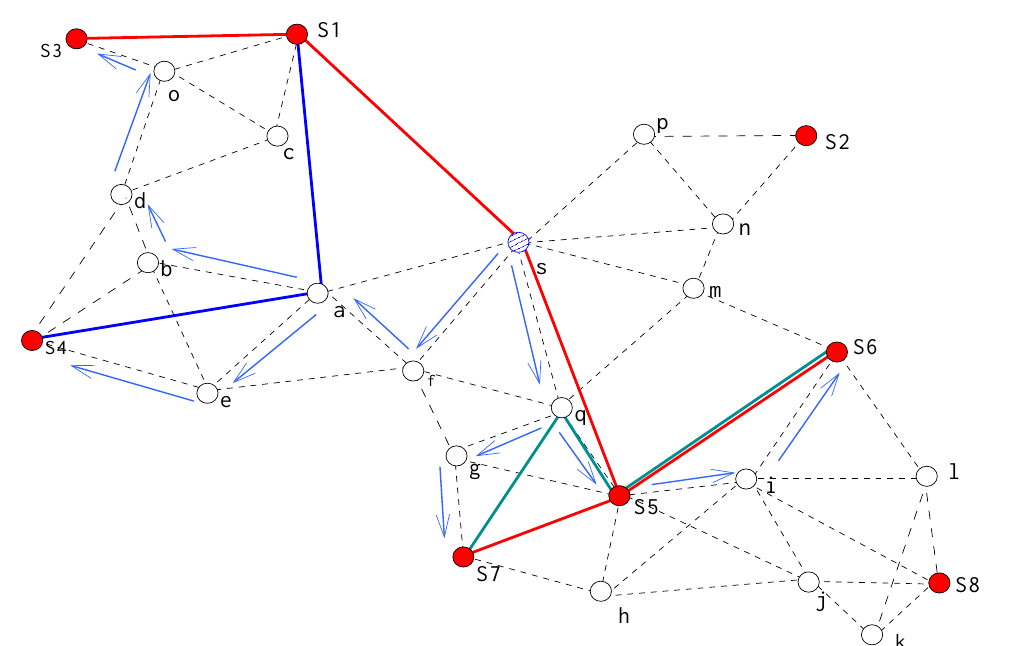
Figure 1. Sinks appear in red. Red links represent the 5 -MST rooted in s , blue links the 2 -MST rooted in a over S green links the 3 -MST rooted in q over S